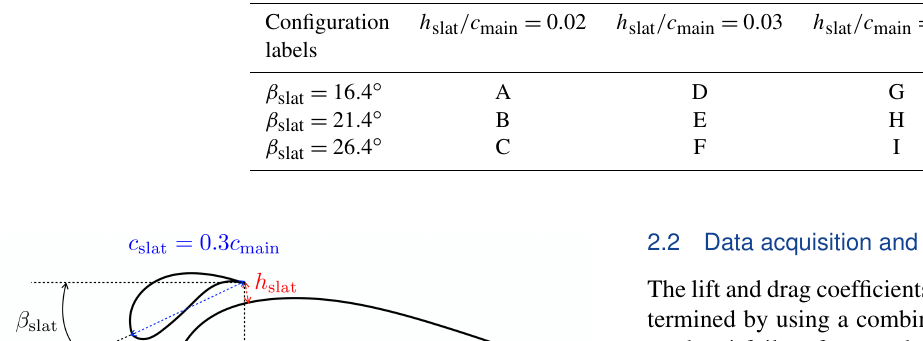
Table 1. Set of configurations and associated labels.